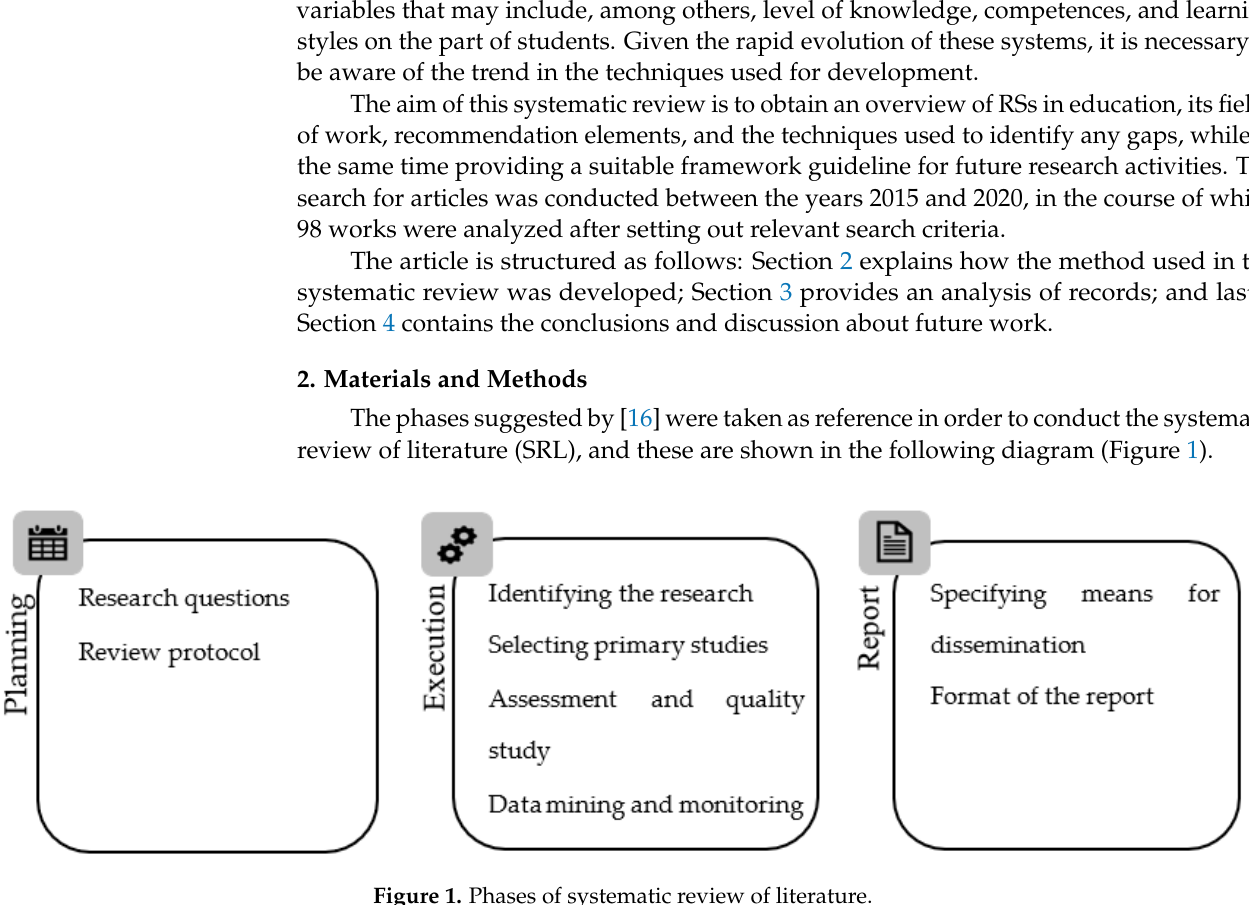
Table 1. Purpose of the search questions.